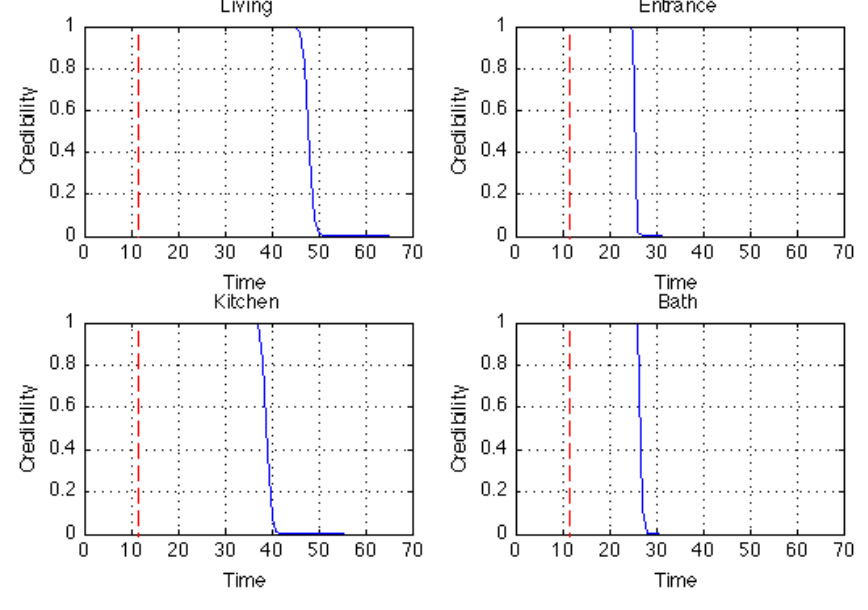
Figure 8. Credibility of each sensor plotted when intrusion from the entrance occurs. The dotted line shows the time when the intrusion started, while the solid line shows the time evolution of credibility for the sensor. Starting from the sensor at the entrance, the credibility of all sensors is lowered because the data do not agree with the profiles of the resident.